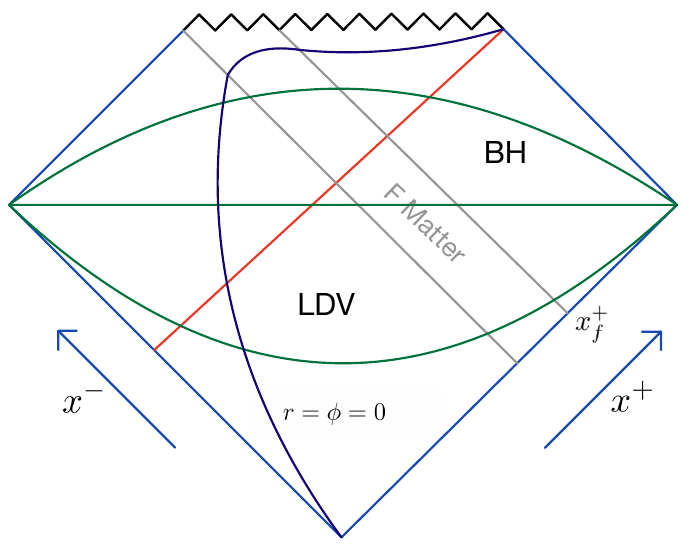
Figure 1 . A Penrose diagram for the black hole (2.19) formed from F matter incident on the linear dilaton vacuum. The incident field turns off at advanced time x + , and the subsequent solution is a f vacuum black hole. Also shown are the horizon in red, a set of spatial slices in green, and the line r = φ = 0 , which can be thought of as an approximate boundary for the strong-coupling